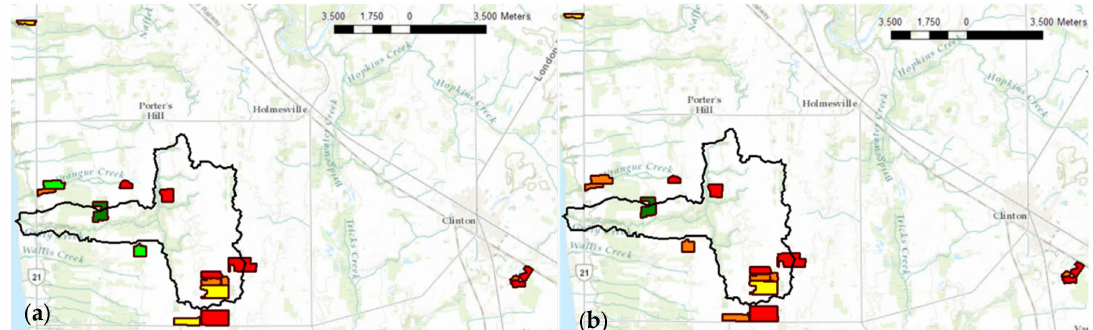
Figure 9. Measured soil-extractable P concentration with regard to crop response to P inputs using ( a ) ERR IFP CV P test; ( b ) Mehlich-3 ICP P test. Legend: (cid:4) too high, (cid:4) high, (cid:4) optimum, (cid:4) low, (cid:4) very